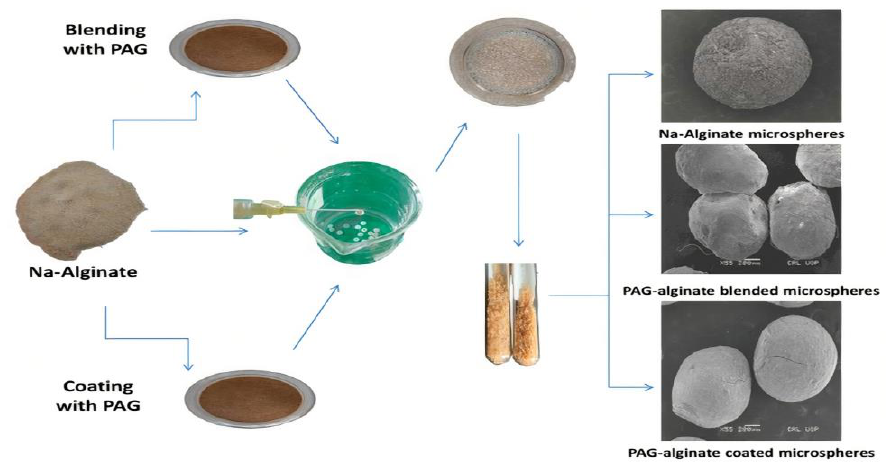
Figure 1. Schematic diagram for preparation of TRHC-loaded alginate and PAG-alginate blended and coated microspheres.